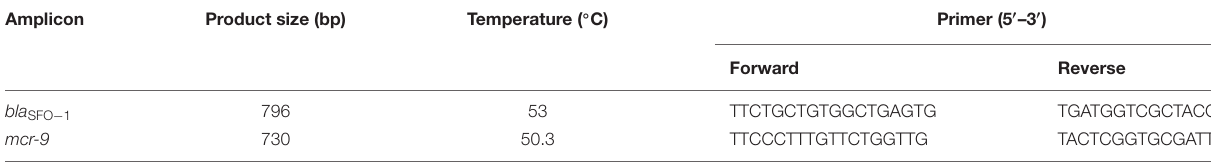
TABLE 1 | Primers used in this study.